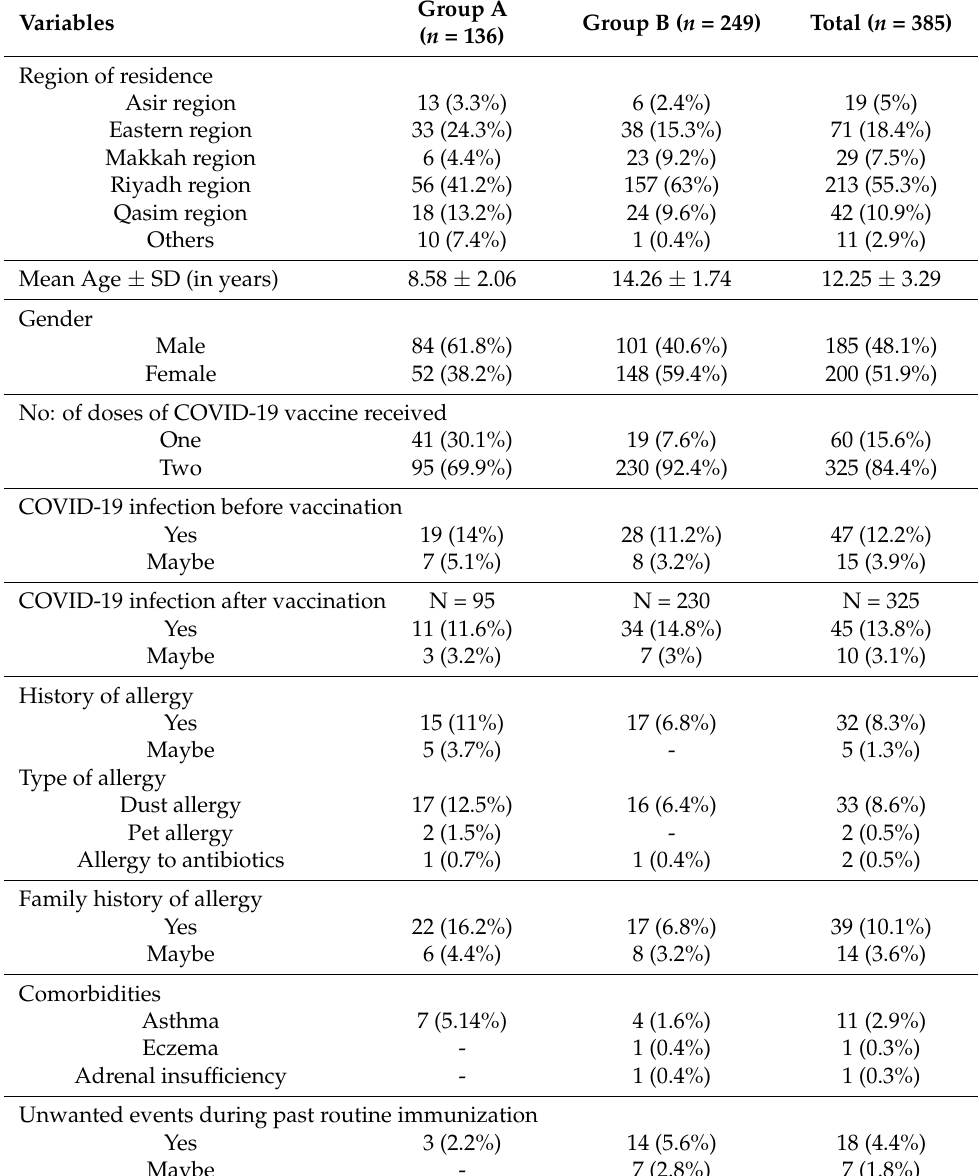
Table 1. Demographic profile of children in group A (5–11 years) and group B (12–17 years of age) who received Pfizer-BioNTech’s mRNA-COVID-19 vaccine. The percentage is given in parentheses. $ = patients having COVID-19 infection after 2nd dose of